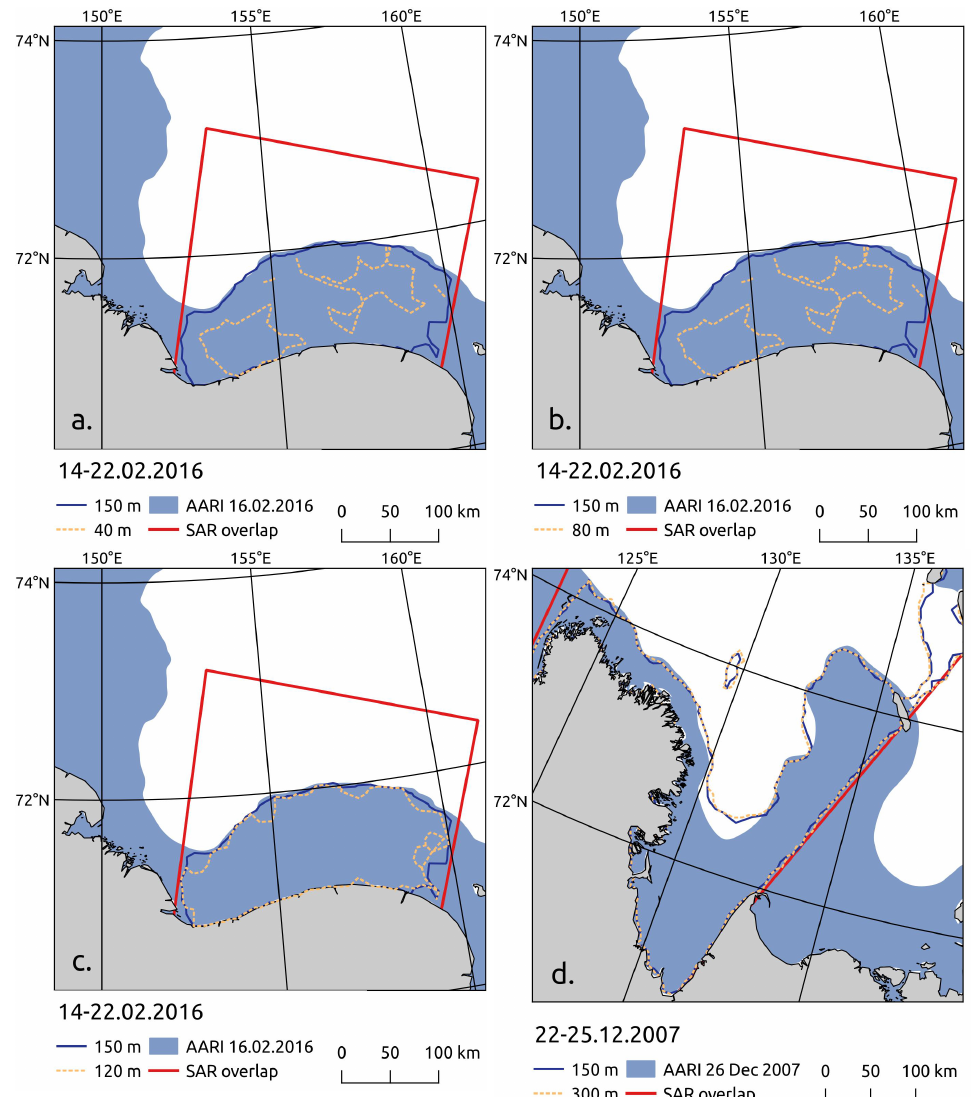
Figure A1. Algorithm sensitivity to the varying displacement threshold tested with Sentinel-1 ( a – c ) and ENVISAT data ( d ). The red lines indicate the overlap of the processed SAR images. The dashed yellow and dark blue lines show the derived fast ice polygons. The fast ice from the AARI chart is shown in light